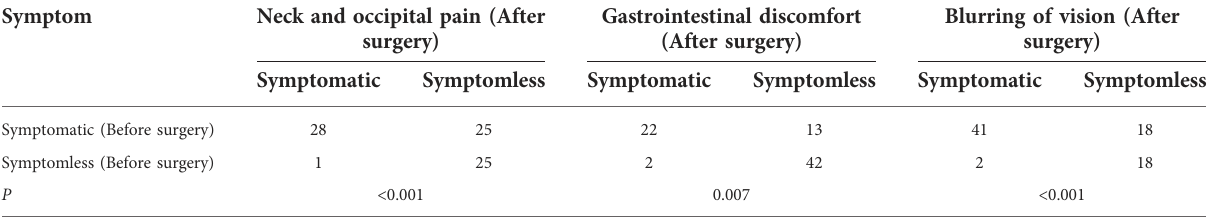
TABLE 9 Number of patients with neck and occipital pain, gastrointestinal discomfort or blurring of vision before and after surgery. (x±, n =79). Symptom